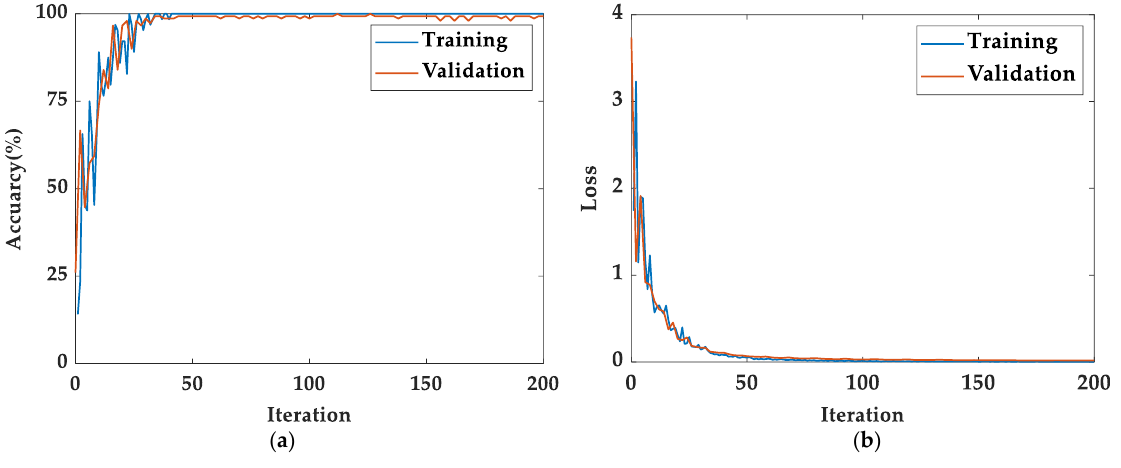
Figure 9. The WPE-CNN model training process: ( a ) accuracy (%); ( b ) loss.